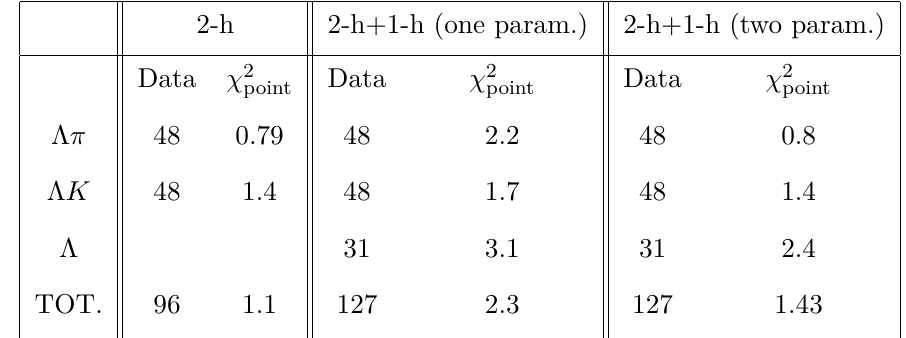
Table 5 . χ 2 per data points for the 2-h, 2-h+1-h (single parametrization) and 2-h+1-h (double parametrization) fits, adopting the Power-Law model.